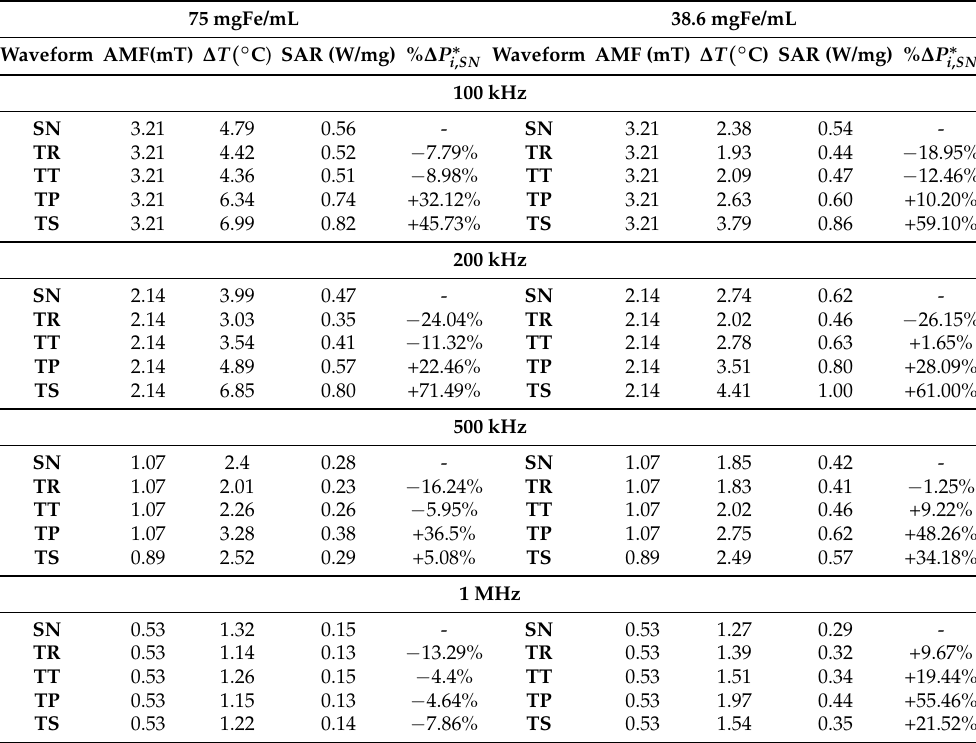
Table 2. Thermal power increment ratio calculation of the values from Figures 8, 10 and 11. 75 mgFe/mL 38.6